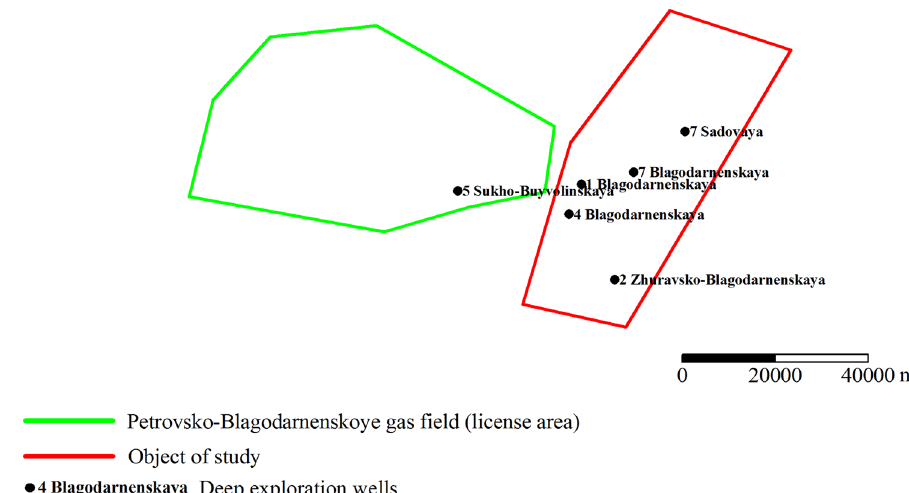
Fig. 7 Location of deep-explo- ration wells used in reservoir evaluation